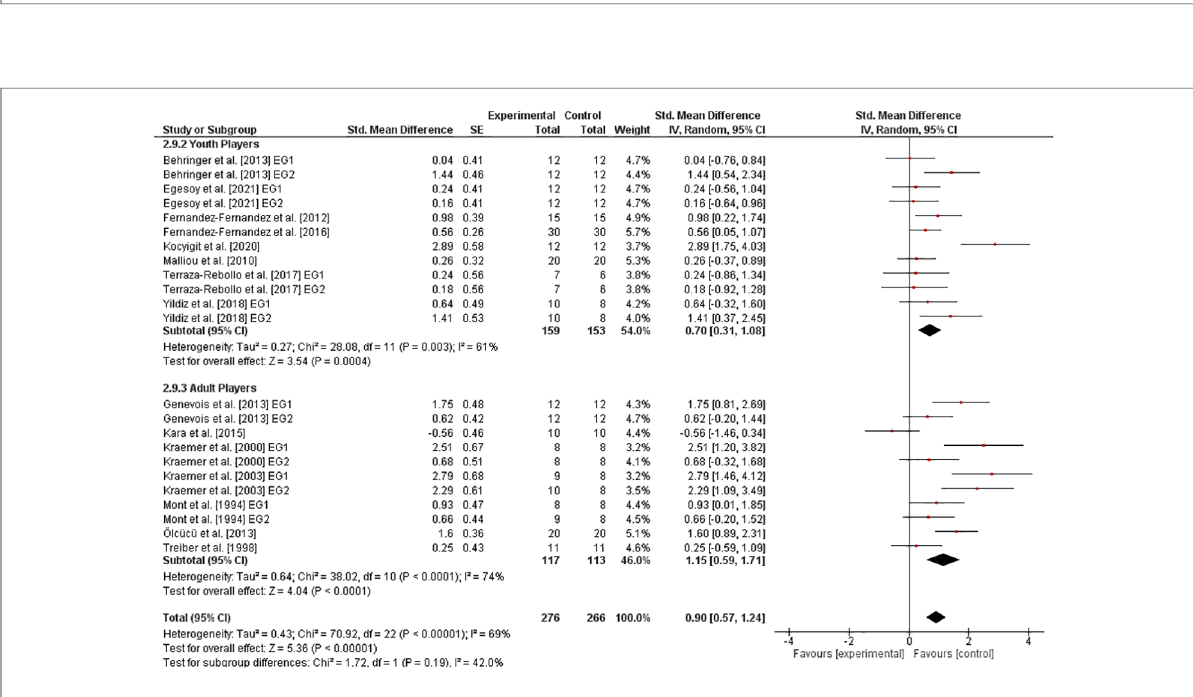
FIGURE 10 Effects of athletic training on measures of stroke performance (e.g., maximal stroke velocity) in healthy youth and adult tennis players. CI = con fi dence interval, df =degrees of freedom, SE =standard error, IV =inverse